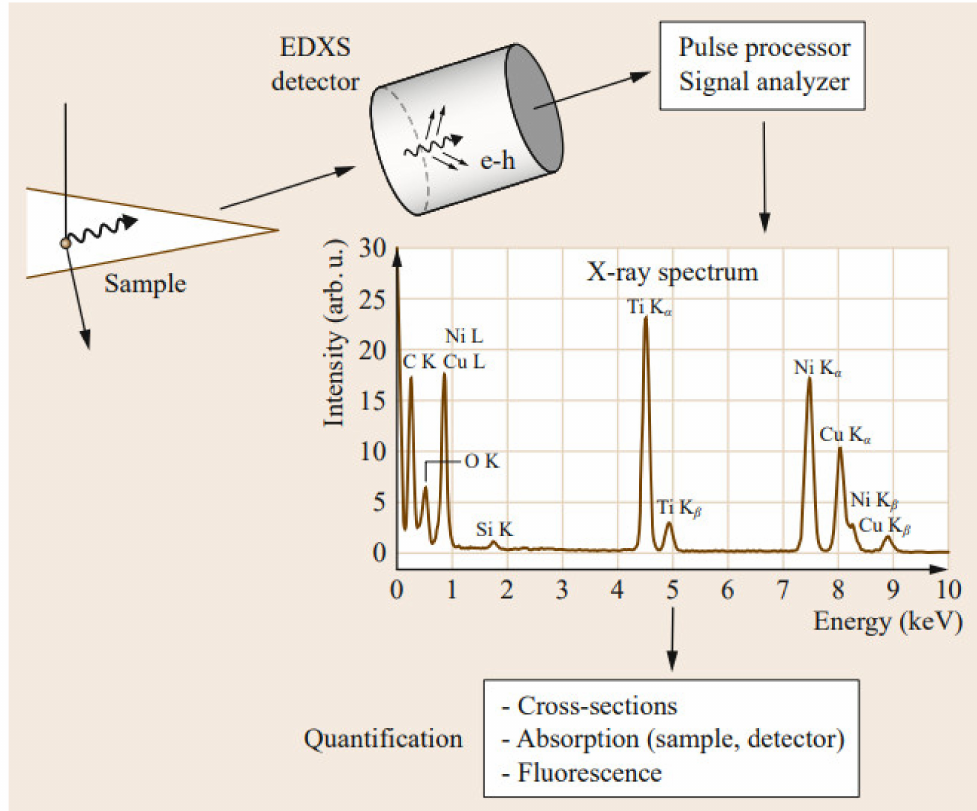
Figure 15. Schematic diagram showing the generation of X-rays in the sample, detection of the X-rays by the detector (using generation of electron and hole pairs), pulse analysis and quantification process of the spectrum to derive the composition of the sample [102]. Reprinted from Science of microscopy, Scanning Transmission Electron Microscopy, Peter D. Nellist, New York, NY, 2007, 65–132. Springer, Copyright (2007), with per-mission from Springer Science+Business Media,